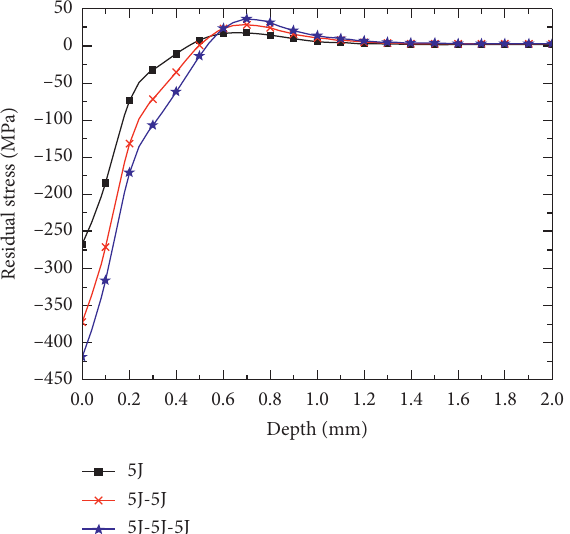
Figure 13: Curves of residual stress distribution of the in-depth direction of sample surface with different number of